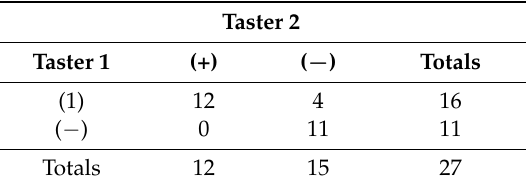
Illustrating the Relationship between the Reliability and Accuracy of Wine Tasters’ Hypothetical Binary Judgments of Whether a Wine is Oaked (+) or Not Oaked ( − ), Expressed in